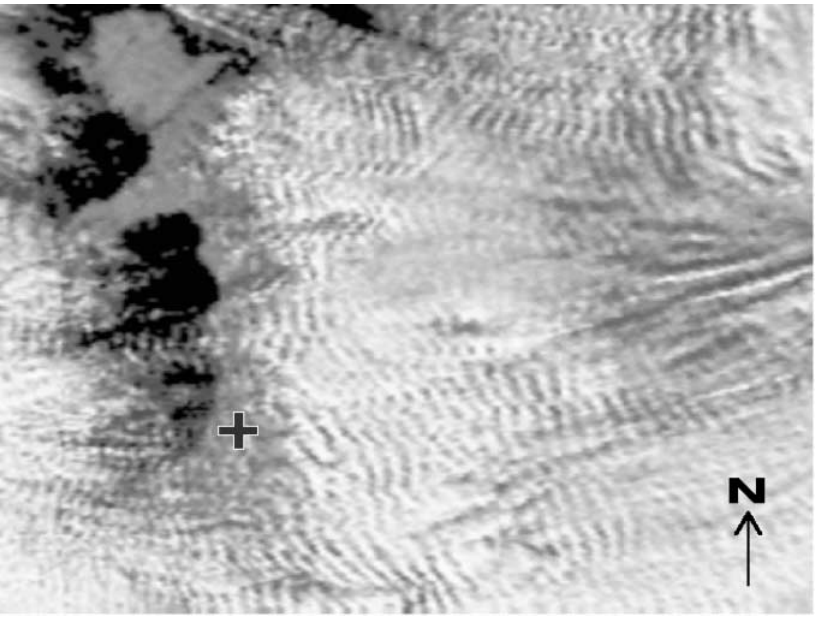
Fig. 6. Visible-light satellite image at 1333 GMT, 8 January 1997 (Courtesy of the University of Dundee). The MST radar site is marked by a cross . The coastline of north- west Wales can be seen in a cloud-free region downwind of the